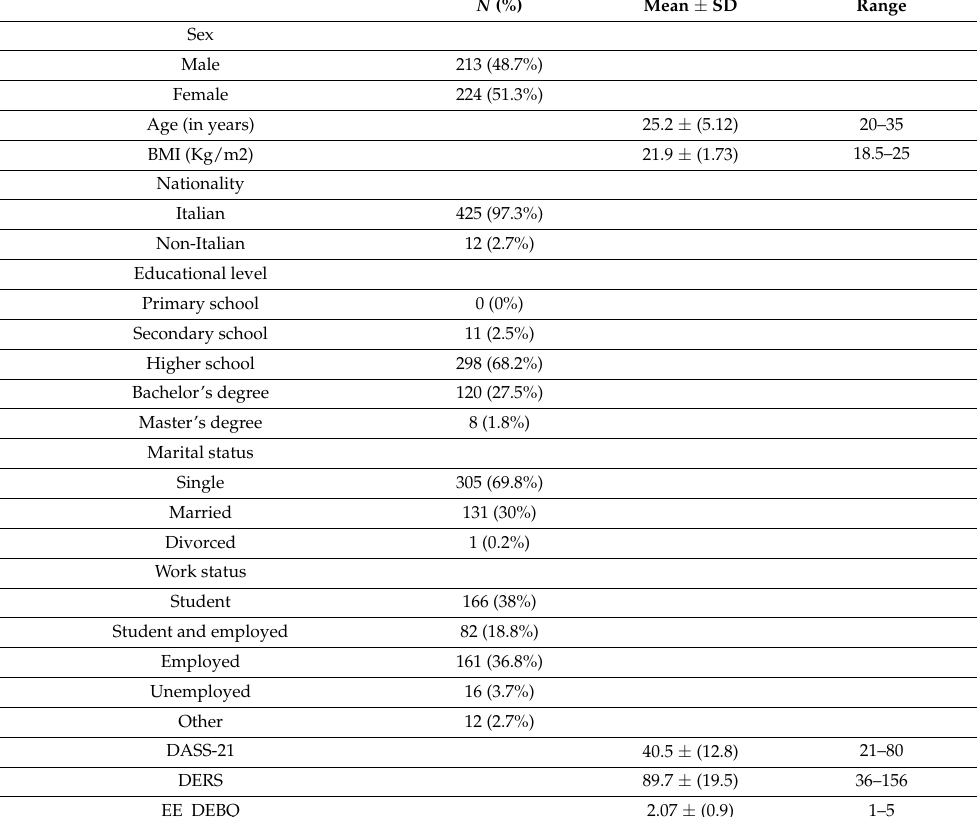
Table 1. Descriptive statistics of the sample.